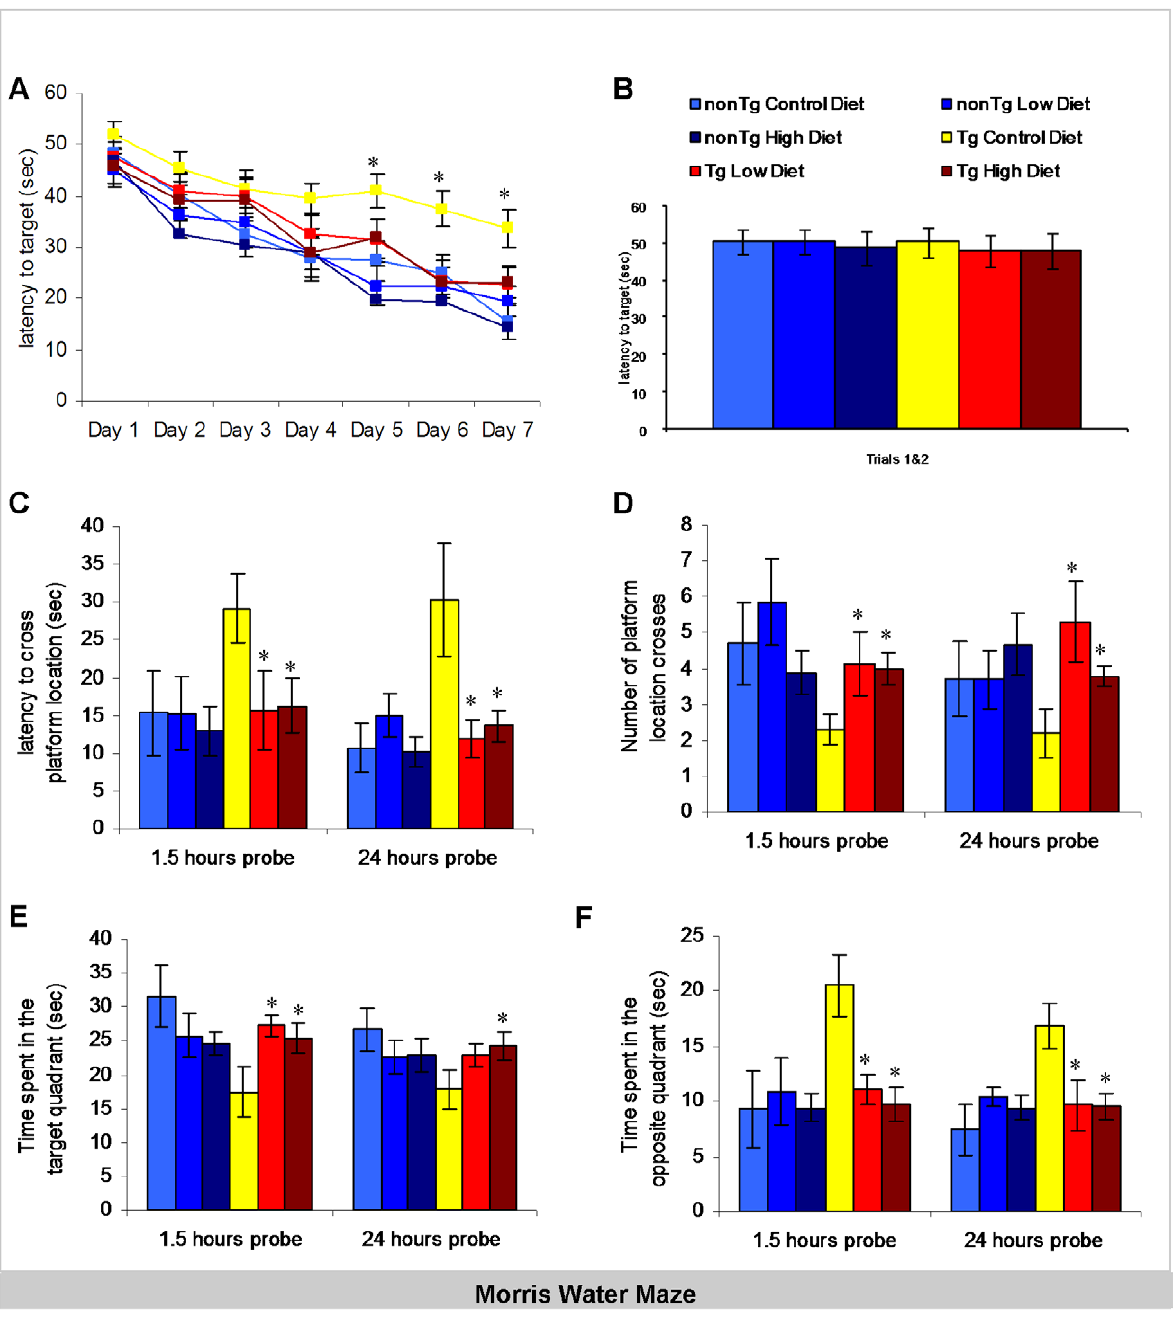
Figure 1. Prevention of hippocampal spatial memory deficits with medical food cocktail diet in Tg2576 mice. Medical food cocktail was given to Tg2576 and non-transgenic control (nonTg) mice at 6 months of age, at a low and high (3x higher) dose. After 5 months of treatment, mice were tested for cognitive functioning on hippocampal and cortical dependent tasks. Mice were trained and tested on the spatial memory version of the Morris water maze (MWM; n=10 per group). A) Acquisition curves shown for the 7 days of training on the MWM. Non-transgenic mice perform better as compared to Tg2576 starting day 2 of training (Genotype main effect day 2 F(1,45) 3.586, p=0.0599, day 3 F(1, 45) 4.611 p=0.0332, day 4 F(1, 45) 4.832, p=0.0519, day 5 F(1, 45) 13.812, p=0.003, day 6 F(1, 45) 4.021, p=0.0465 and day 7 F(1, 45) 15.821, p=0.0001). NonTg mice on the control diet perform significantly better on day 7 as compared to day 1 of training (p , 0.0001). Tg2576 mice on the control diet also exhibited learning during the acquisition phase of the test (day 1 compared to day 7 p , 0.05) but were unable to reach the 25 sec criterion after 7 days of training. Medical food cocktail improved the spatial learning of Tg2576 during training (low diet day 5 p , 0.05, day 6 p , 0.01, day 7 p=0.1034; high diet day 5 p , 0.01, day 6 p , 0.001, day 7 p , 0.01) with mice reaching criterion by day 7 of training. B) All mice started at the same level as shown by the average of trials 1 and 2 on the 1 st day of training (Genotype main effect F(1, 104) 0.094, p=0.9107, treatment main effect F(2, 104) 0.233, p=0.7928). C–F) Mice were given a memory probe with the platform removed at 1.5-h or 24-h following the last training trial. C) Tg2576 mice took significantly longer to reach the platform location as compared to non-transgenic mice on the control diet (p , 0.05 for both 1.5 and 24-hour probe trials). Tg2576 mice treated with medical food cocktail exhibited significantly decreased latencies to cross the platform location compared to vehicle- treated mice (p , 0.05 for both 1.5 and 24-hour probe trials for both low and high diet treatments). D) The deficits in memory were also evident in the